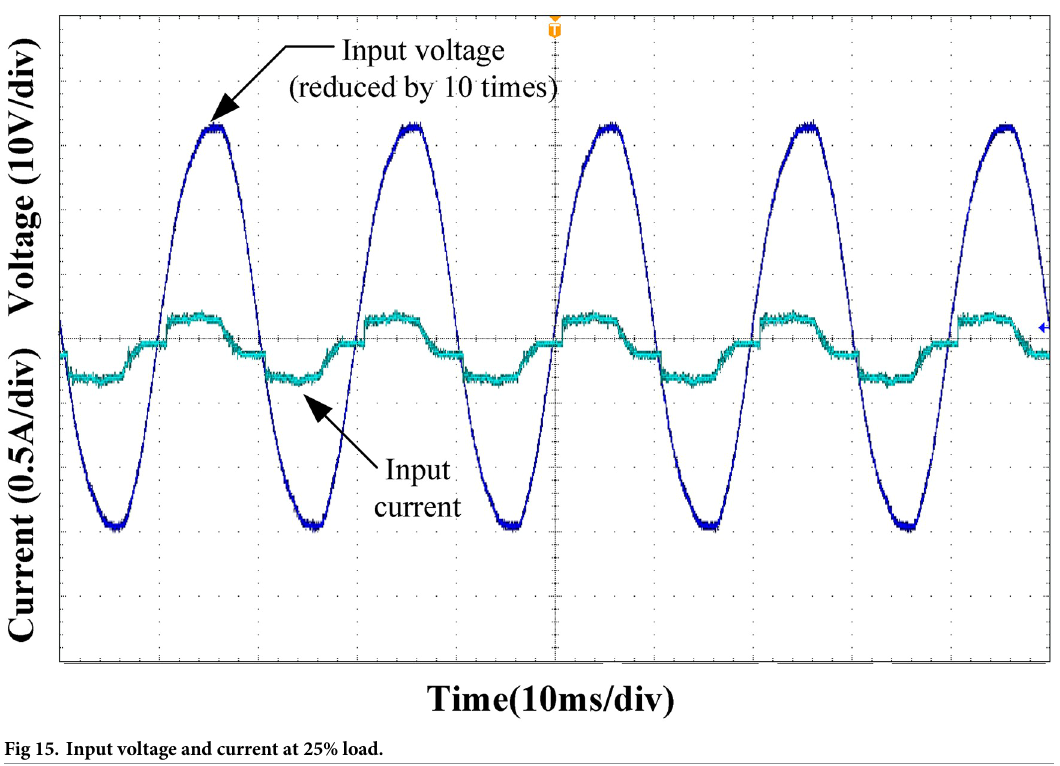
Fig 15. Input voltage and current at 25%